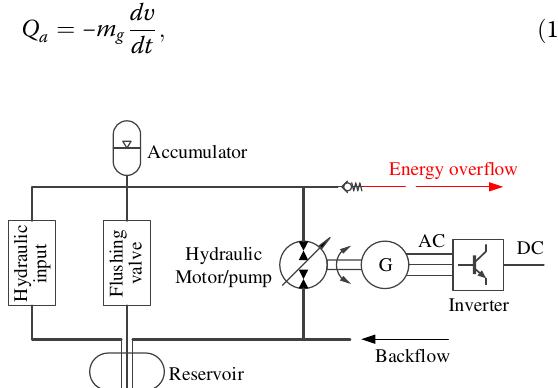
Fig. 1 Hydraulic energy storage and conversion